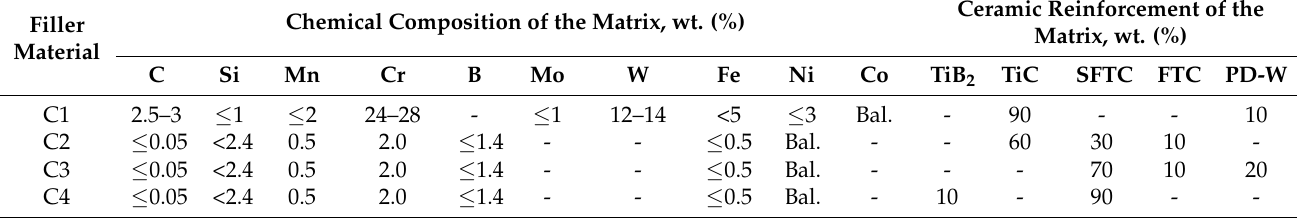
Table 3. Chemical composition of